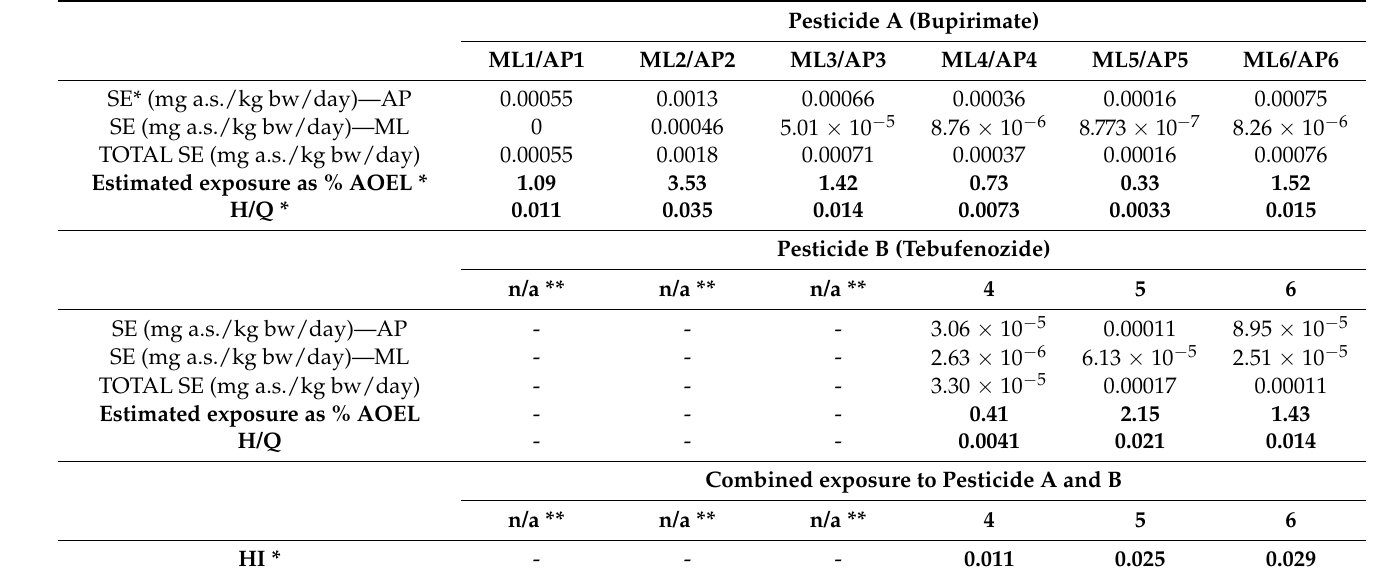
Table 8. Systemic exposure to bupirimate (pesticide A) and tebufenozide (pesticide B): operator risk